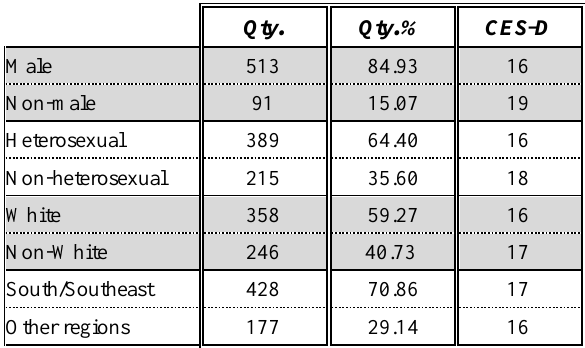
Table 3 : Detached results by identity